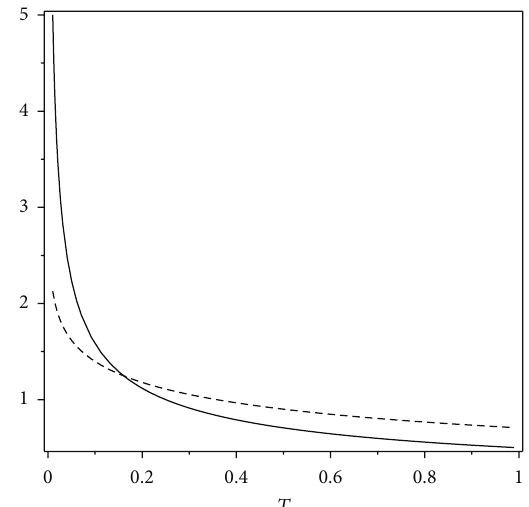
Figure 1: The probability distributions of the components of the tensor T : 𝑃 1 (𝑇) = 𝑃 2 (𝑇) = 𝑃 3 (𝑇) = 1/(2√𝑇) , for 𝑇 ∈ (0,1] (solid line), and 2𝑃 4 (|𝑇|) = 2𝑃 5 (|𝑇|) = 2𝑃 6 (|𝑇|) , for 𝑇 ∈ [−1,0) ∪ (0, 1] (dashed